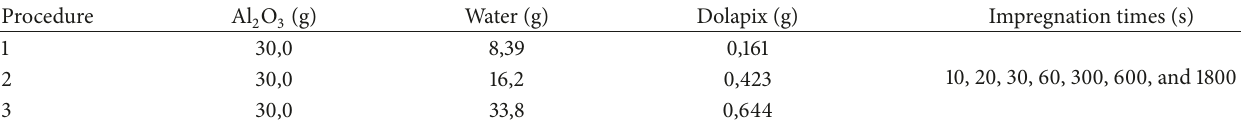
Table 1: Ratio of components and impregnation times used in the optimization of the impregnation process of 3D structures with Al 2 O 3 .